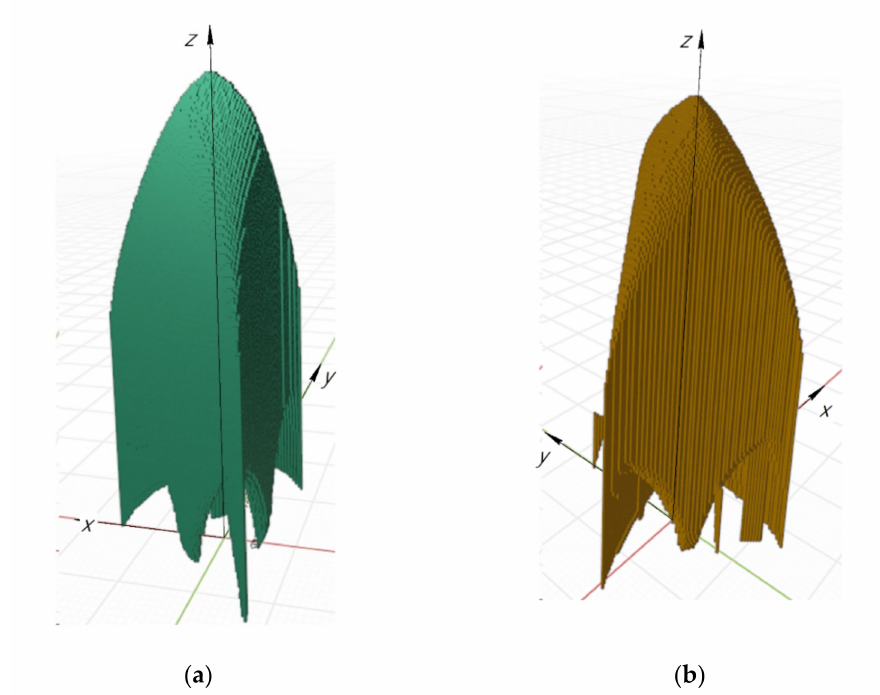
Figure 6. Workspace of the parallel manipulator—( a )—for the range of angles θ and ψ ± 90 ◦ , ( b )—for the range of angles θ and ψ ± 95 ◦